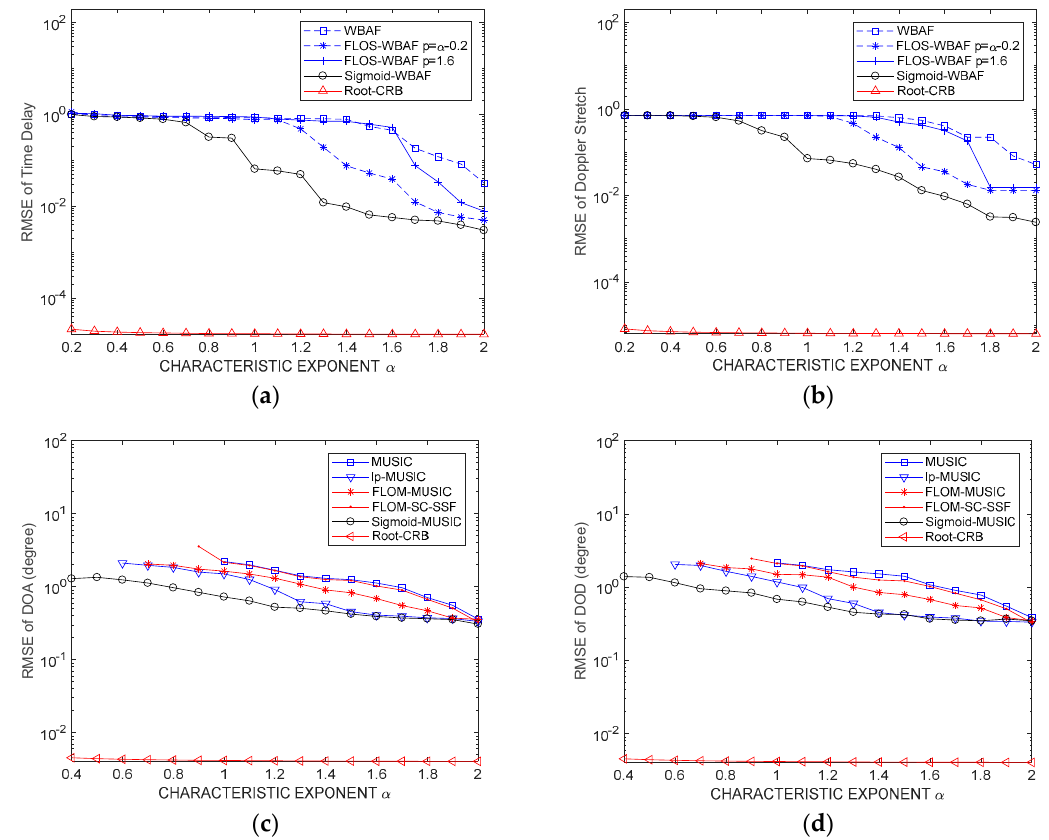
Figure 8. RMSEs of the parameters versus characteristic exponent α . ( a ) RMSE of the time delay; ( b ) RMSE of the Doppler stretch; ( c ) RMSE of the DOD; ( d ) RMSE of the DOA.